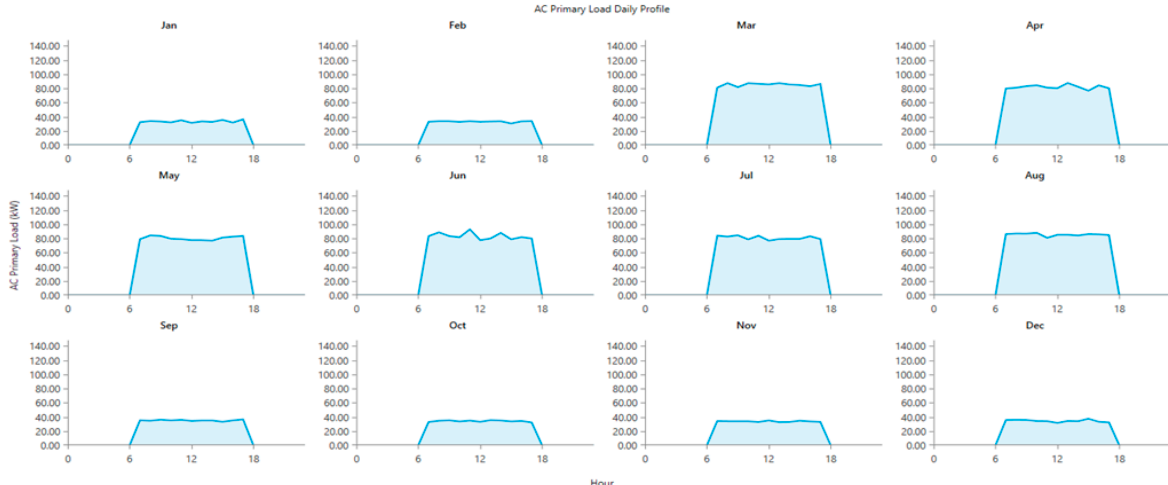
Figure 12. Daily load profile.